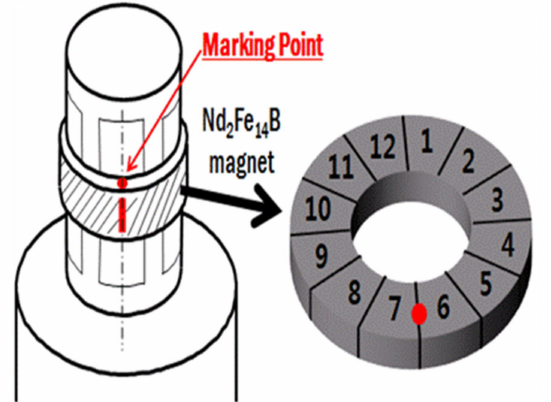
Figure 6. Schematic illustration of magnetization yoke and Nd 2 Fe 14 B permanent magnet used for the preparation of specimens.